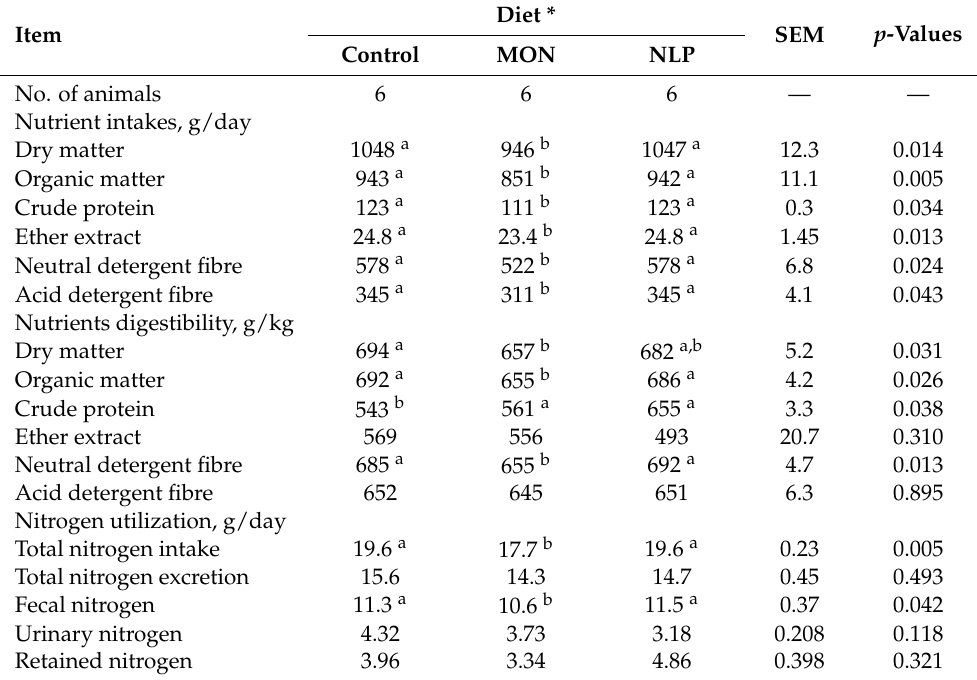
Table 3. Influence of neem leaf powder or monensin supplementation on nutrient intake, apparent digestibility, and nitrogen utilization of Omani growing lambs (collection period = 6 consecutive